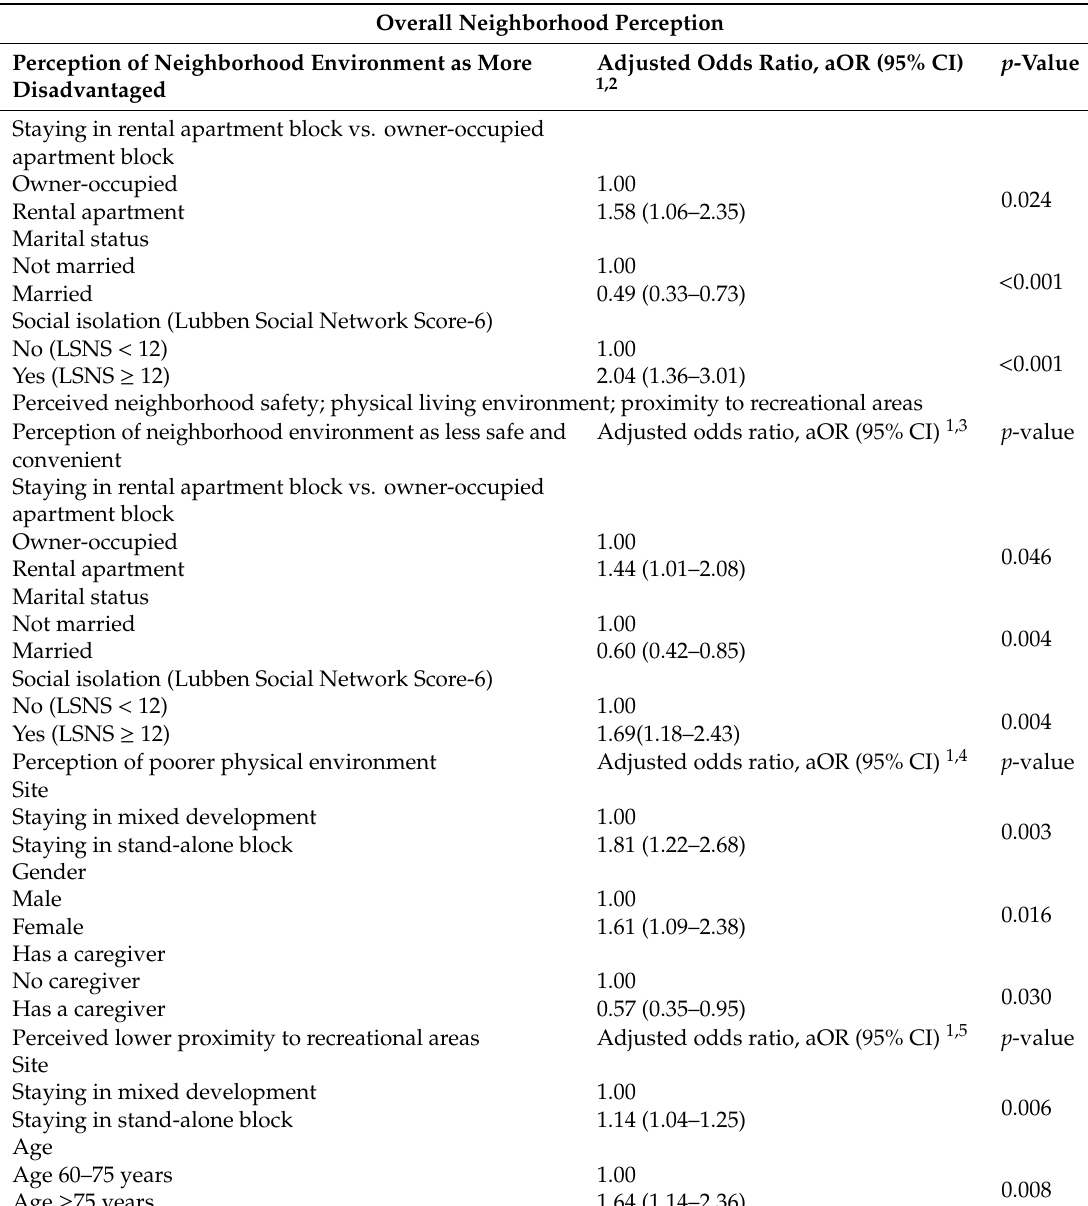
Associations between perception of neighborhood environment and geographical, sociodemographic, medical and social factors, amongst residents in two public housing precincts in Singapore, on multivariate analysis ( n = 528). Overall Neighborhood